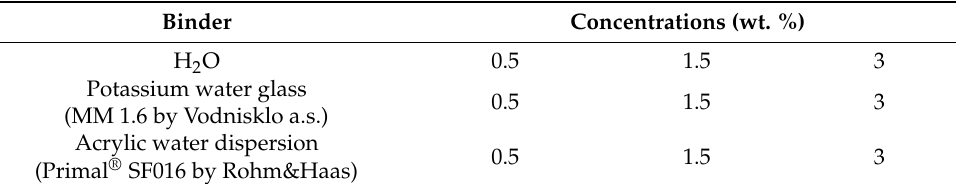
Table 1. Binders and concentrations of TiO 2 in the mixtures.